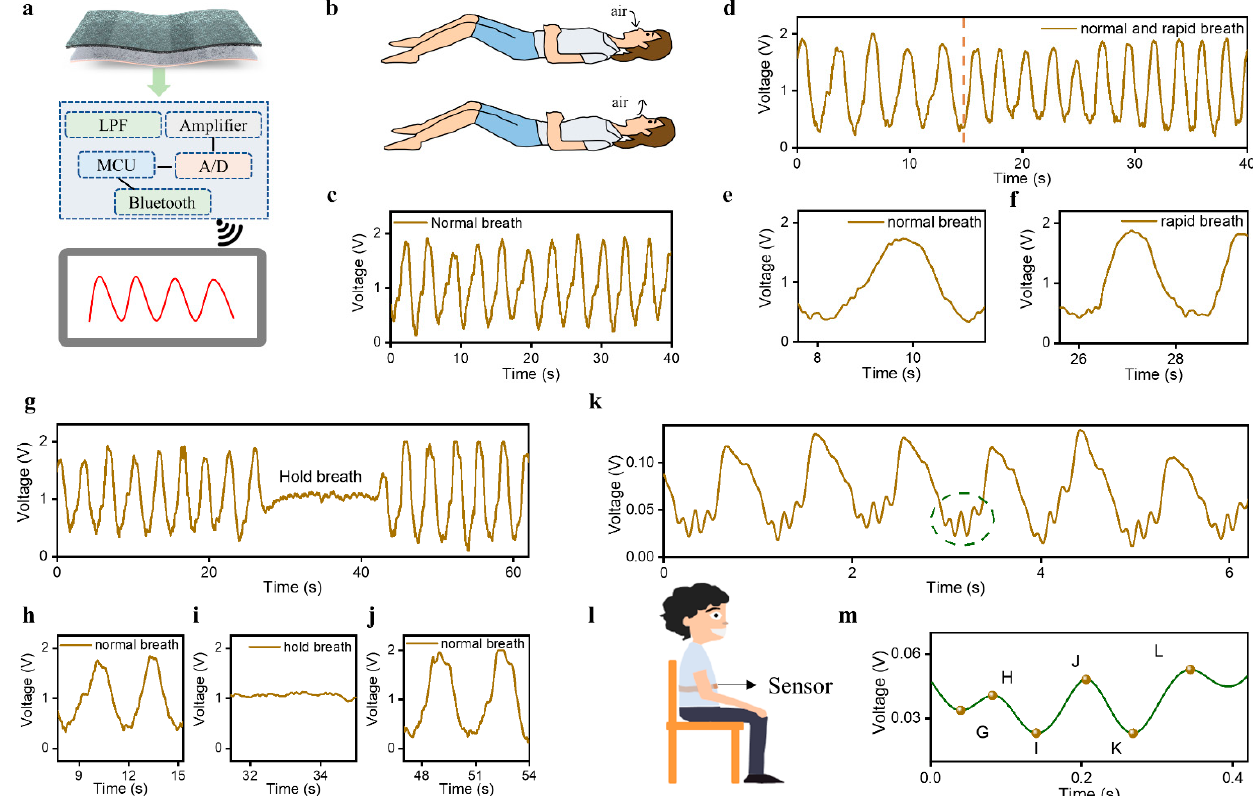
Figure 3. Multiple physiological signal monitoring. ( a ) Schematic diagram of pulse signal monitoring system composition. ( b ) The abdominal state of an individual during normal breathing. ( c ) Respiratory signals are measured by the sensor in normal breath. ( d ) The measured waveforms under two different breath conditions (normal and rapid breathing). ( e , f ) The respiratory signals of 3.9 s in different breath states (normal and rapid breathing). ( g ) Dynamic monitoring of respiratory signals under different states ( h ) normal breathing, ( i ) holding breathing, and ( j ) back to normal breathing. ( k ) BCG signals. ( l ) Schematic diagram of BCG test process. ( m ) A typical BCG waveform contains six prominent peaks: the presystolic (G), the systolic (H, I, J, K), and the diastolic (L).